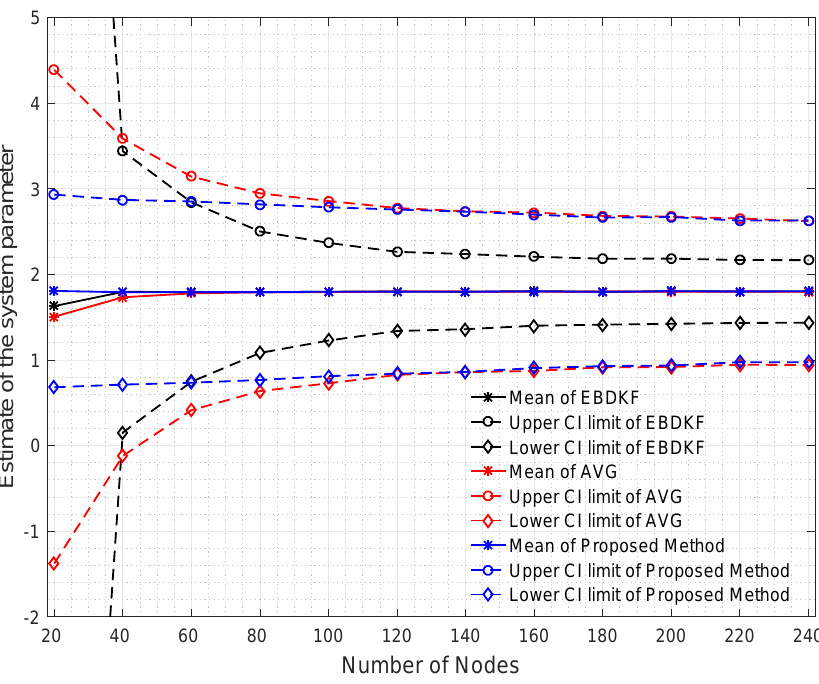
Figure 13. Network Mean estimate and 95% confidence interval limits for a true state of 1.80; compared among the proposed statistical, EBDKF, and AVG information fusion methods in a tree-based IoT platform for different number of sensor